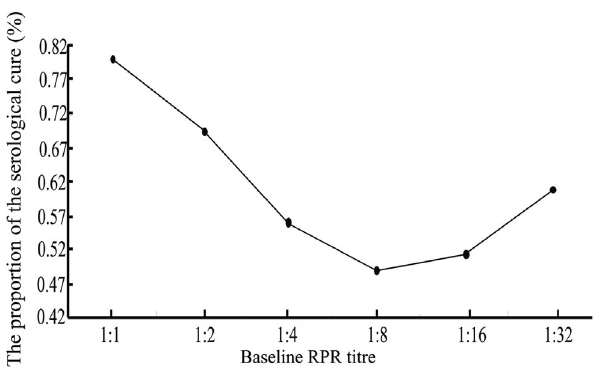
Figure 3. The proportion of serological cure by baseline RPR titre. * The proportion of the serological cure changed with changes in the baseline RPR titre. Overall, the patients with lower or higher baseline RPR titres were more likely to achieve a serological cure ( X 2 =74.12, P ,